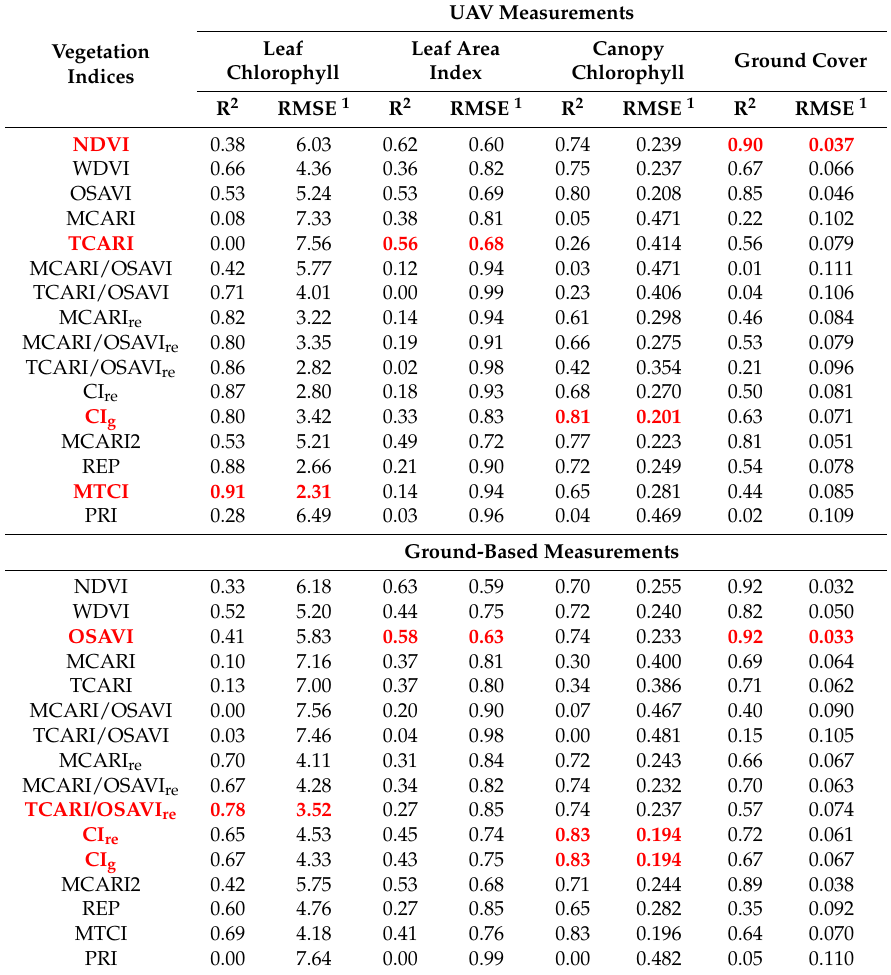
Table A1. Coefficient of determination and RMSE (from repeated 10-fold cross-validation) for linear regressions between crop traits and vegetation indices calculated from UAV and ground-based data acquired on the last four acquisition dates (from 62 to 99 DAP). Indices with best prediction performance for UAV and ground-based measurements are indicated in red ( n =